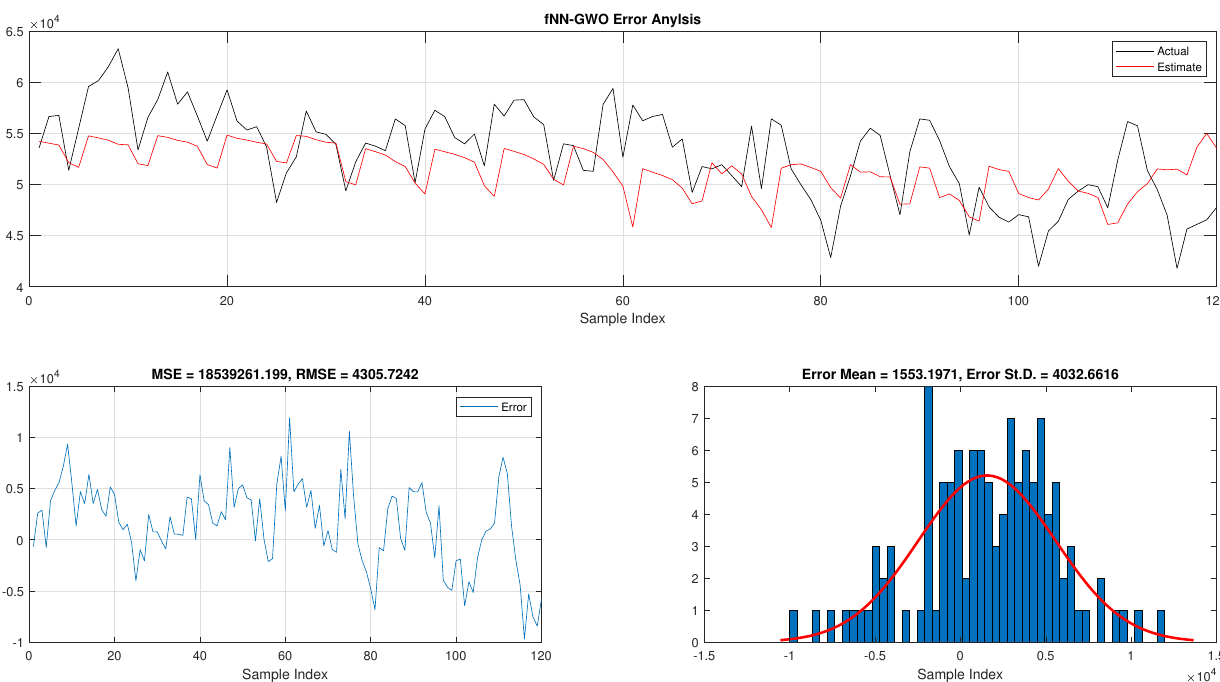
Figure 7. Error analysis of the total daily load consumption with fNN-GWO best